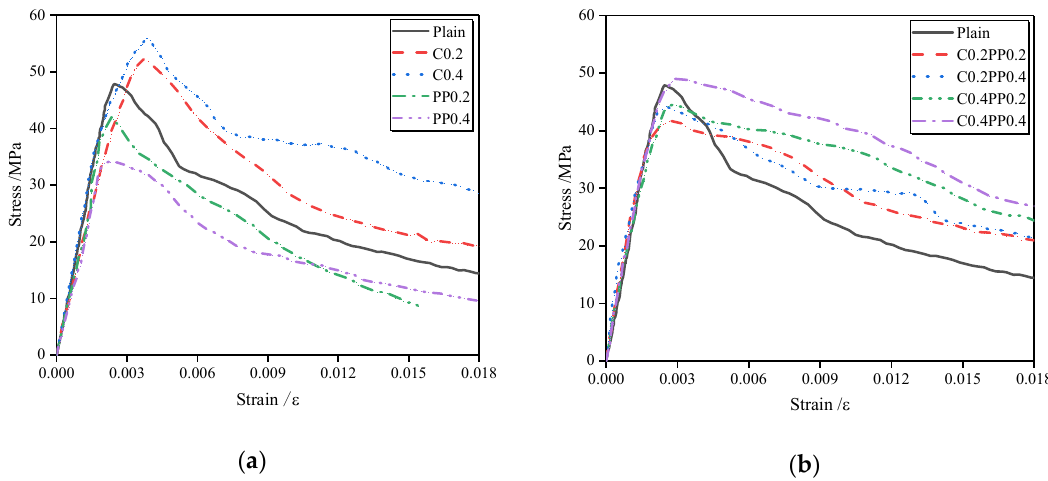
Figure 12. The e ff ect of carbon and / or polypropylene fiber on the compressive stress–strain curves: ( a ) Figure 12. The effect of carbon and/or polypropylene fiber on the compressive stress–strain curves: fiber in single form; ( b ) fiber in hybrid ( a ) fiber in single form; ( b ) fiber in hybrid form.